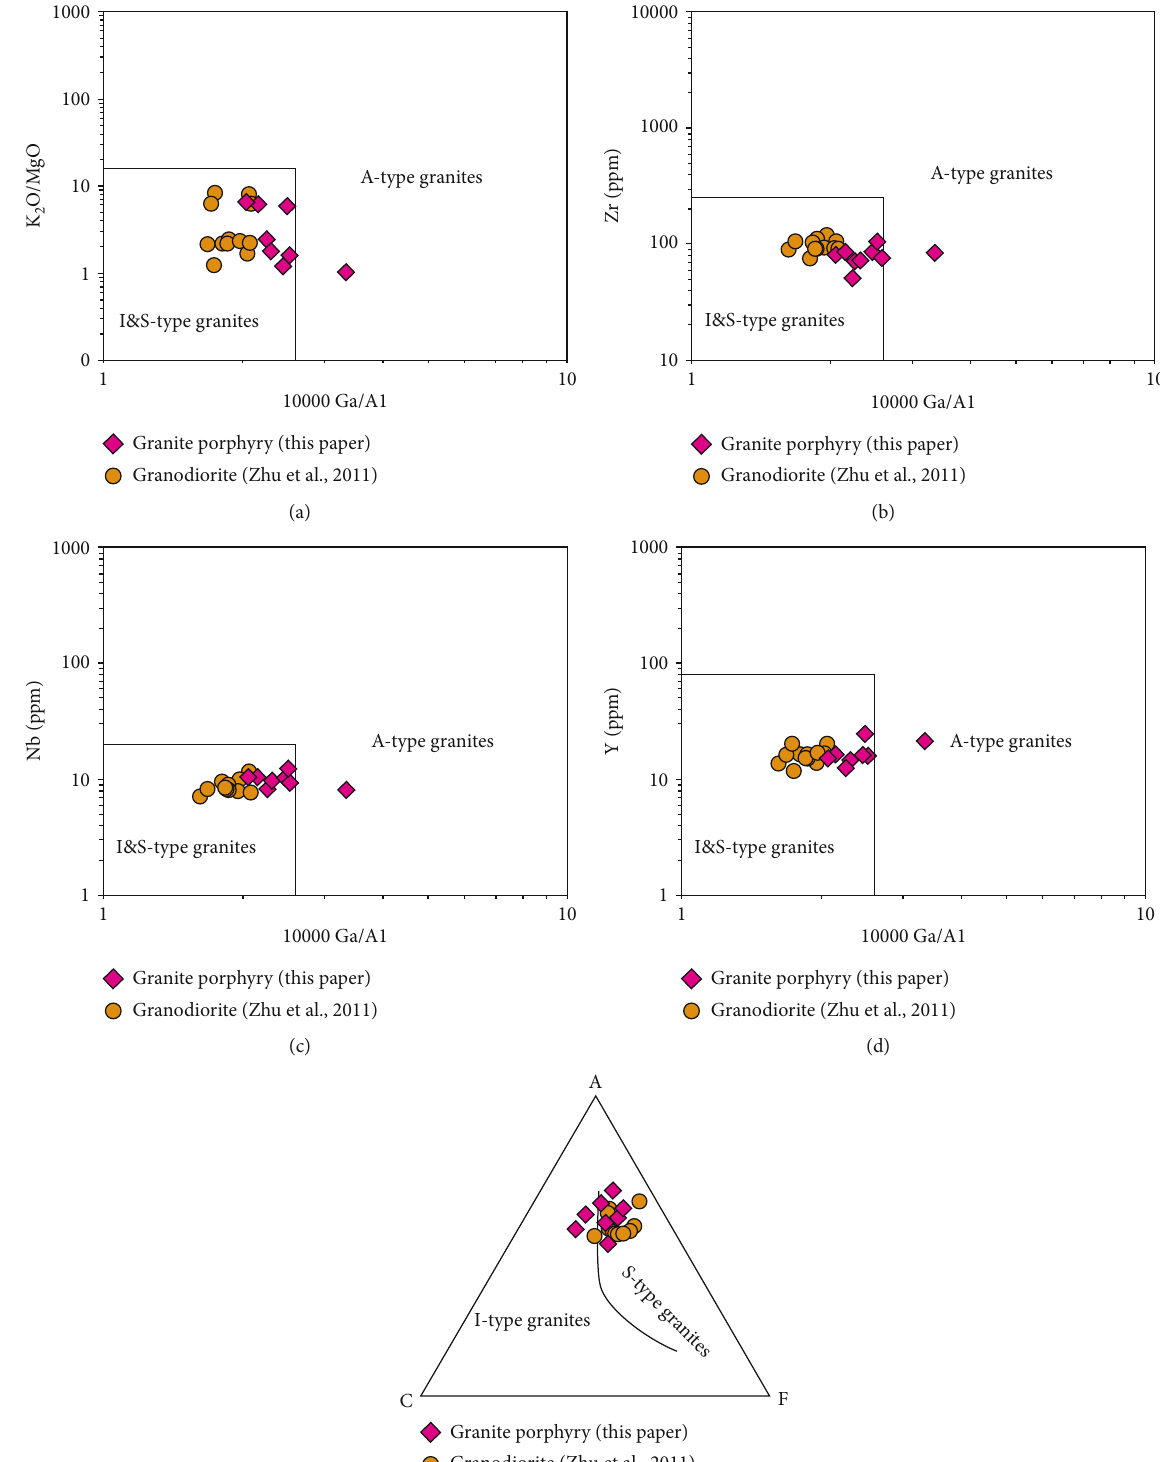
Figure 17: Plot of major elements (K in Yangla copper deposit, Yunnan, China (after Whalen, 1987 [80]) A = Al + MgO + MnO